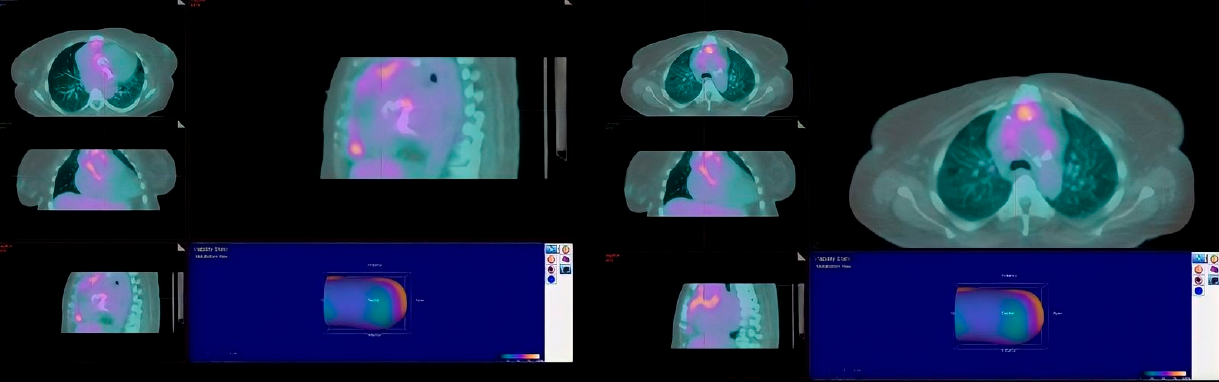
Figure 3. Cardiac PET scan showing increased FDG uptake around the prosthetic aortic valve and the aortic root, indicating an ongoing inflammatory or infectious process.